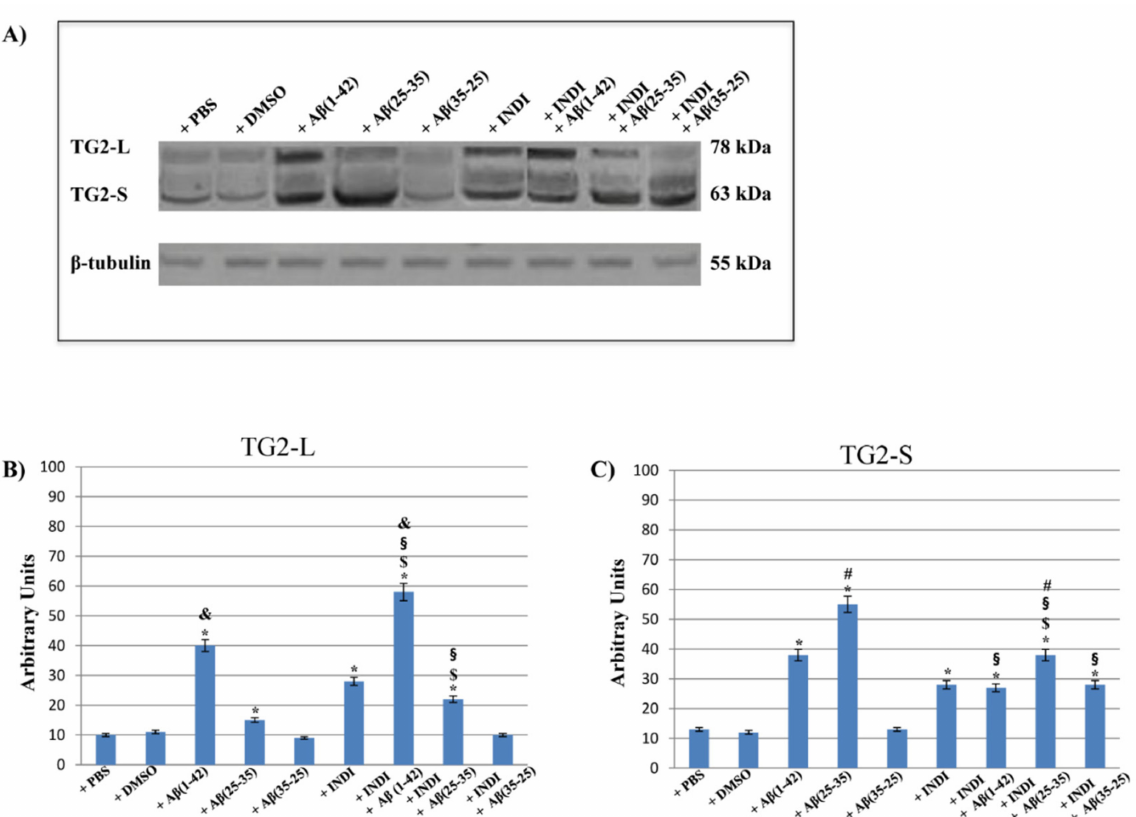
Figure 7. Western blotting analysis. ( A ) Representative immunoblots through western blotting analysis for TG2 isoform (tissue transglutaminase long, TG2-L; tissue transglutaminase short, TG2-S) expression levels in total cellular lysate from OECs in different conditions: control, DMSO, 100 µ M Indicaxanthin (INDI), 10 µ M A β (1-42) or A β (25-35) or A β (35-25) both in the absence and presence of 100 µ M INDI for 24 h; ( B ) Densitometric analysis of TG2-L expression levels performed after normalization with β -tubulin. ( C ) Densitometric analysis of TG2-S expression levels performed after normalization with β -tubulin. The results are expressed as the mean ± S.D. of the values of five separate experiments performed in triplicate. * p < 0.05 significant differences vs. controls; $ p < 0.05 significant differences of A β (1-42) + INDI or A β (25-35) + INDI or A β (35-25) + INDI vs. INDI; § p < 0.05 significant differences of A β (1-42) + INDI vs. A β (1-42), A β (25-35 ) + INDI vs. A β (25-35) or A β (35-25) + INDI vs. A β (35-25); & p < 0.05 significant differences of A β (1-42) vs. A β (25-35) or vs. A β (35-25) and of A β (1-42) vs. A β (25-35) + INDI or vs. A β (35-25) + INDI; # p < 0.05 significant differences of A β (25-35) vs. A β (1-42) or vs. A β (35-25) and of A β (25-35) + INDI vs. A β (1-42) + INDI or vs. A β (35-25) +